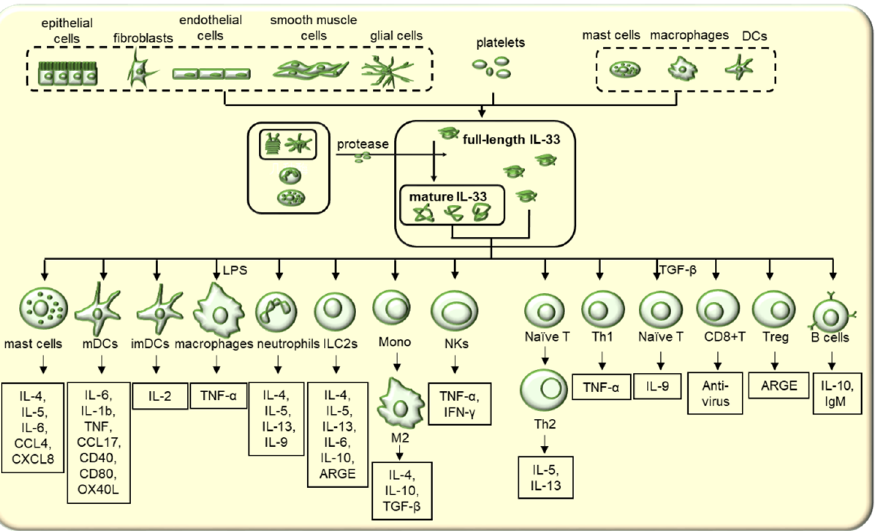
Figure 1. The production and roles of IL-33 in immune responses. Under pathological conditions, full length IL-33 is released by endothelial cells, epithelial cells of barrier tissues such as lung, intestine, skin, and fibroblasts, and also glial cells and astrocytes, smooth muscle cells and platelets and several types of immune cells, including macrophages, dendritic cells (DCs), and mast cells. After cleavage by proteases, highly active IL-33, interacting with ST2, activates different immune cells to generate different cytokines or polarize into the corresponding phenotypes in different pathological conditions.